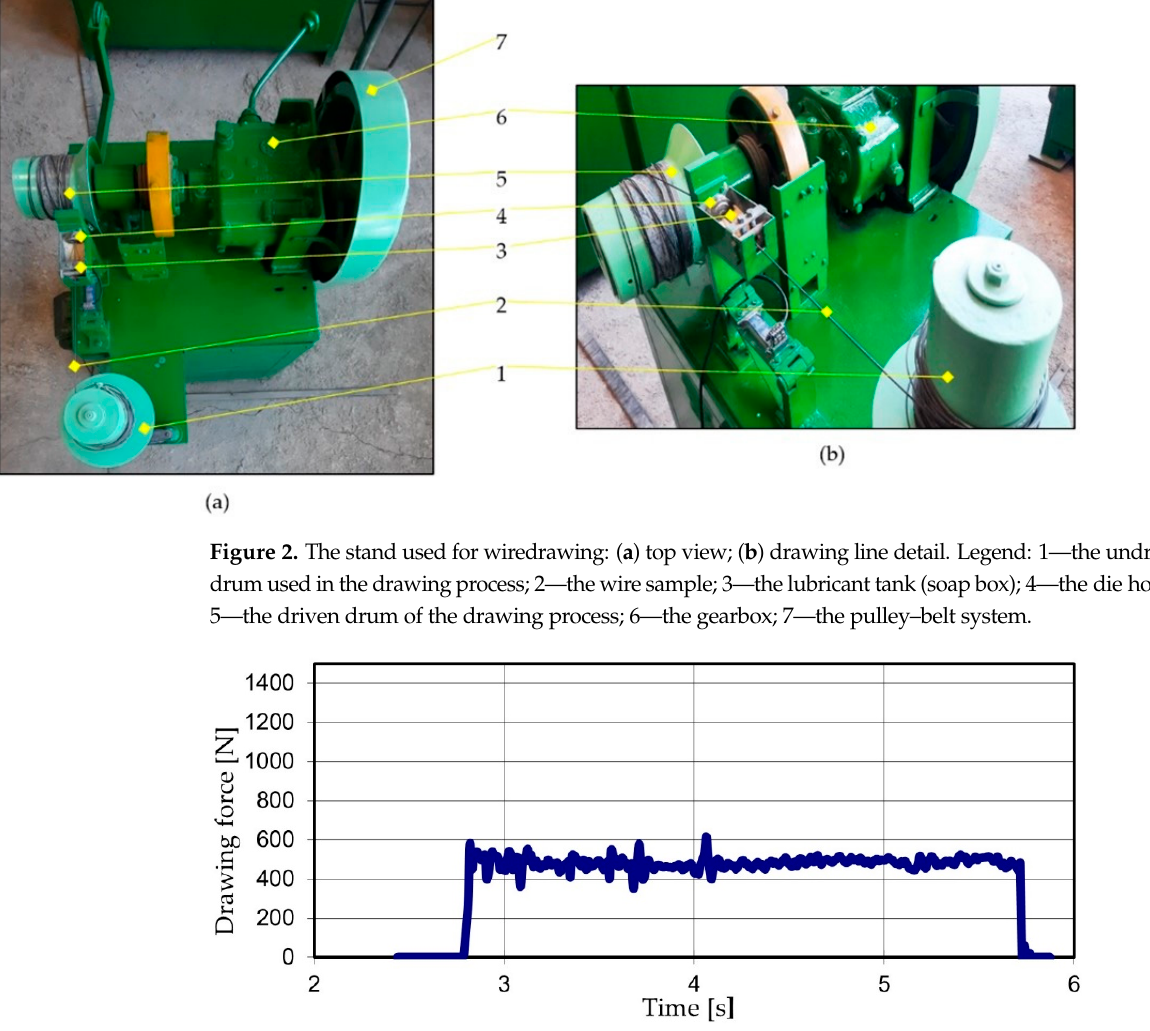
Figure 3. The drawing force recorded for a sample, drawn through a die with the deformation angle 2· α = 10°. 2 · α = 10 ◦ .